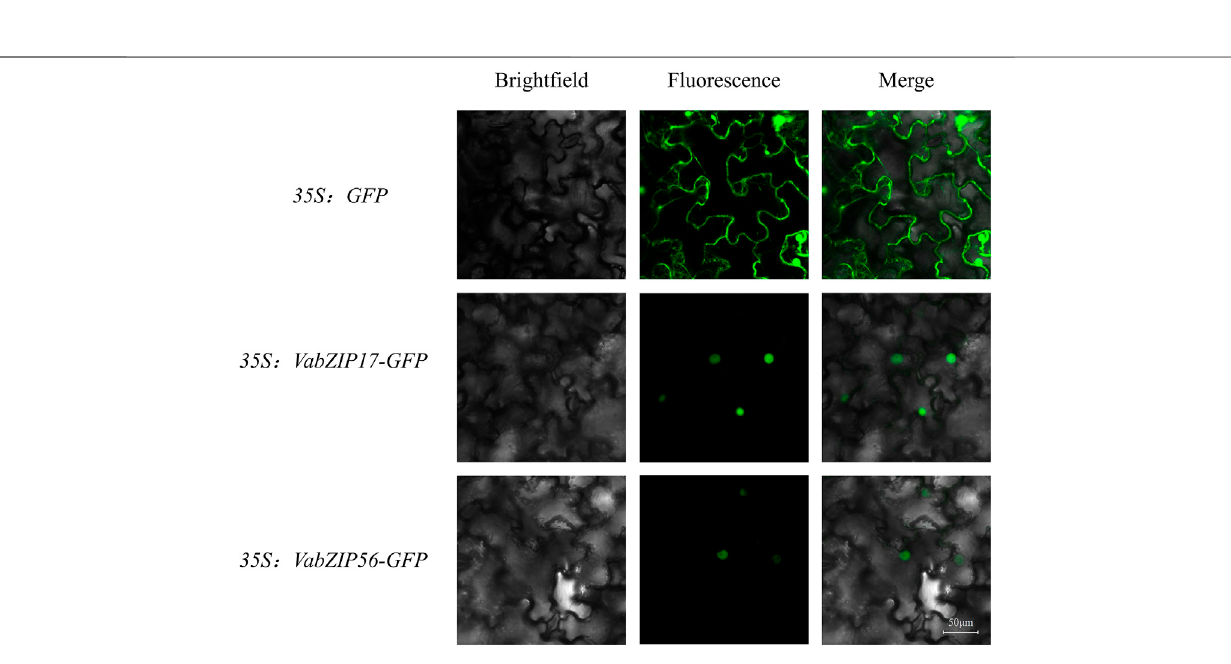
FIGURE 7 | The subcellular localization of VabZIP17 and